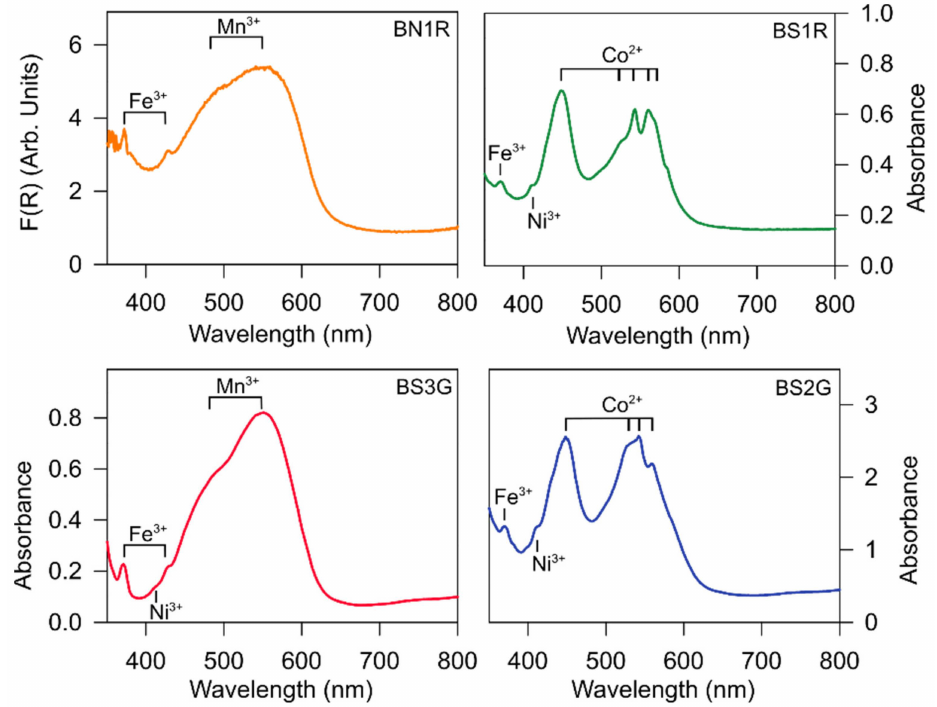
Figure 5. UV–vis–NIR spectra of the natural and synthetic red beryls, collected in the range between 300 and 800 nm. The BN1R spectrum has been collected in reflection mode and data are reported according to the Kubelka–Munk